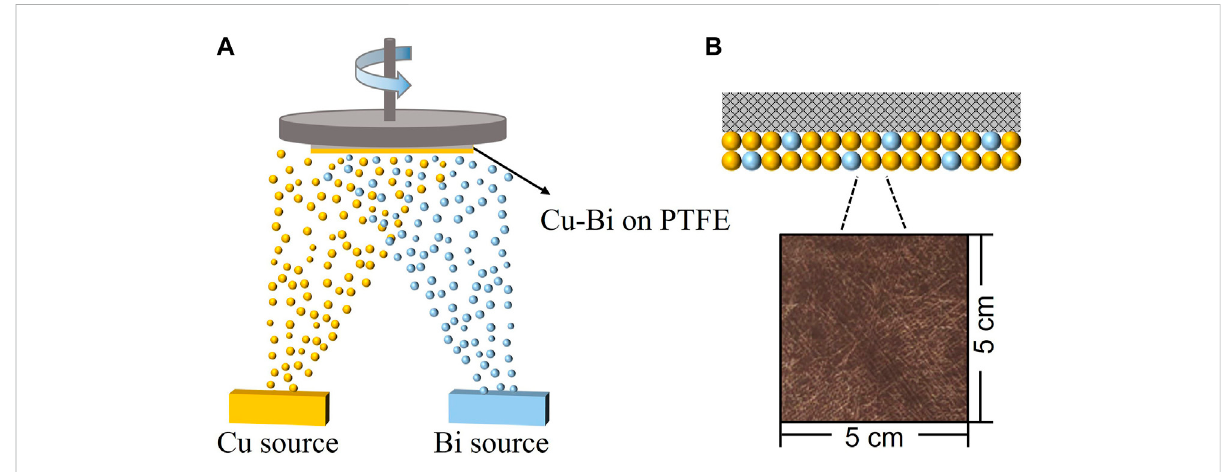
FIGURE 1 (A) A schematic illustration of the synthetic process of Cu-Bi catalyst on polytetra fl uoroethylene (PTFE). (B) The insert optical image shows